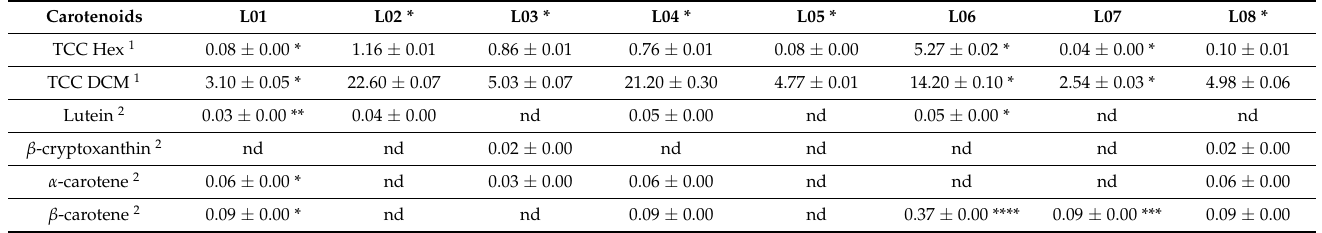
Table 3. Total carotenoid contents (TCC) and carotenoids composition of samples